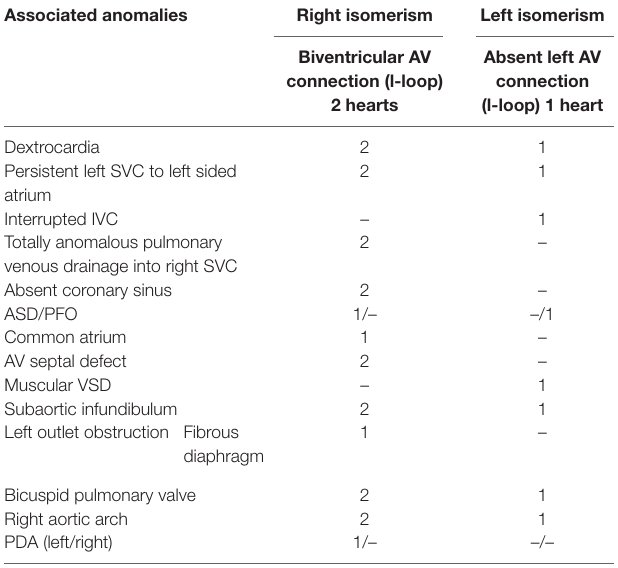
TaBle 13 | Discordant Va connection in isomerism: associated anomalies. associated anomalies right isomerism left isomerism